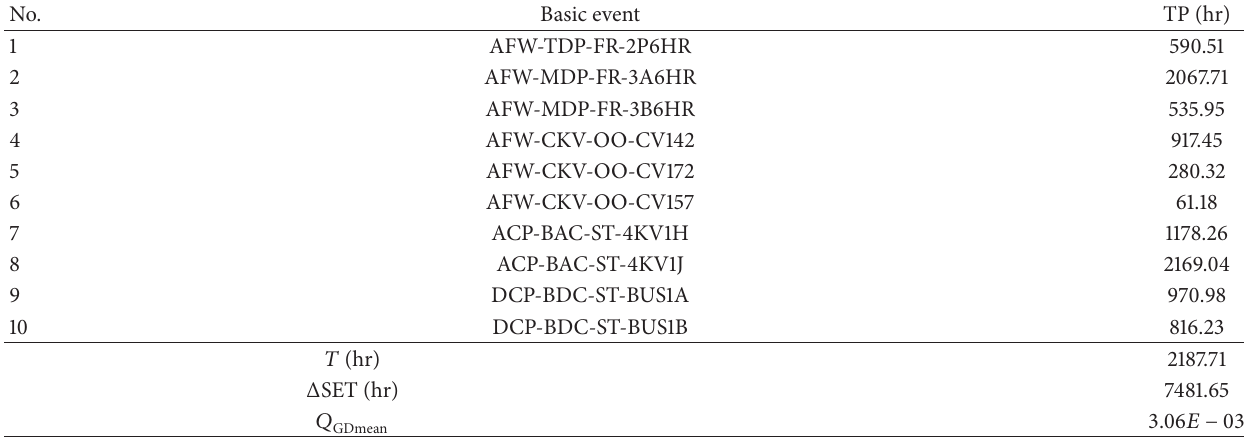
Table 7: Obtained optimal test placement times for case scenario 2, no constraints considered.